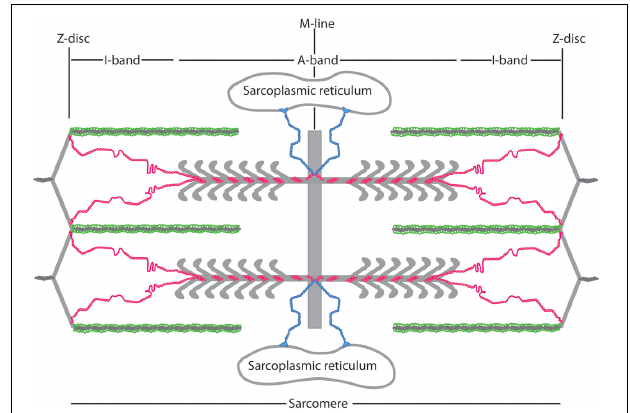
FIGURE 2 | Schematic of nebulin (green), obscurin (blue), and titin (red) arrangement in the sarcomere. Nebulin is oriented with its C terminus in the Z-disc, Obscurin is oriented with its N-terminus in the M-line and its C-terminus bound to the sarcoplasmic reticulum, and titin is oriented with its N-terminus at the Z disc and its C-terminus at the